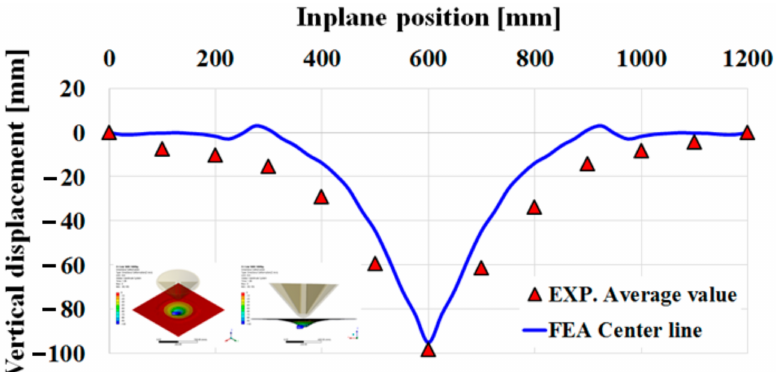
Figure 20. Vertical displacement comparison (drop height of 5 m).